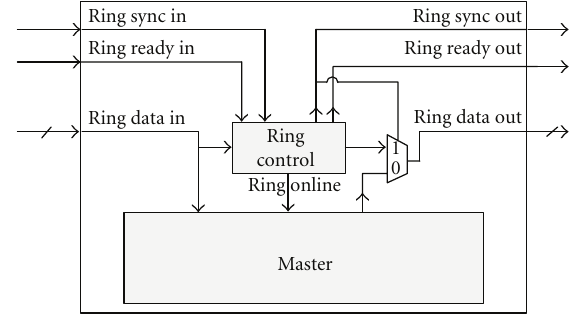
Figure 5: Schematic overview of the master.